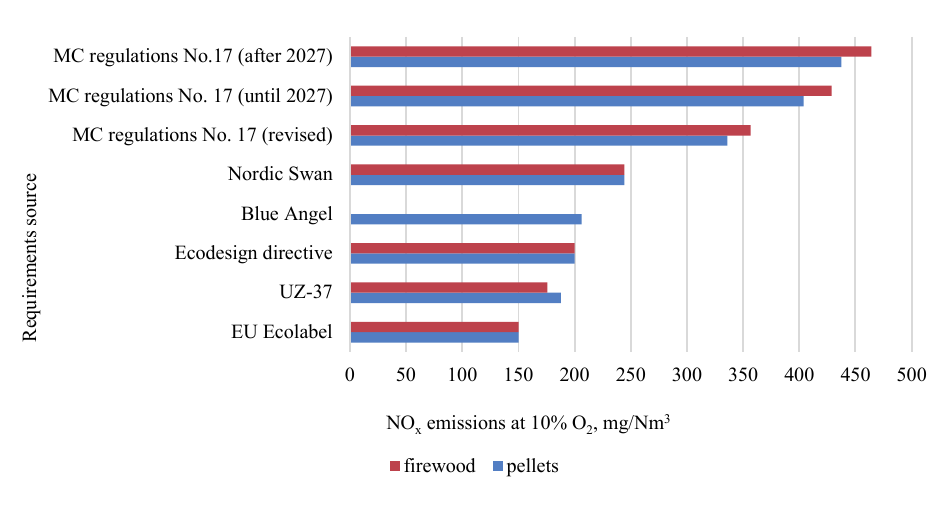
Fig. 5. Requirements for NO x emissions at 10 % O 2